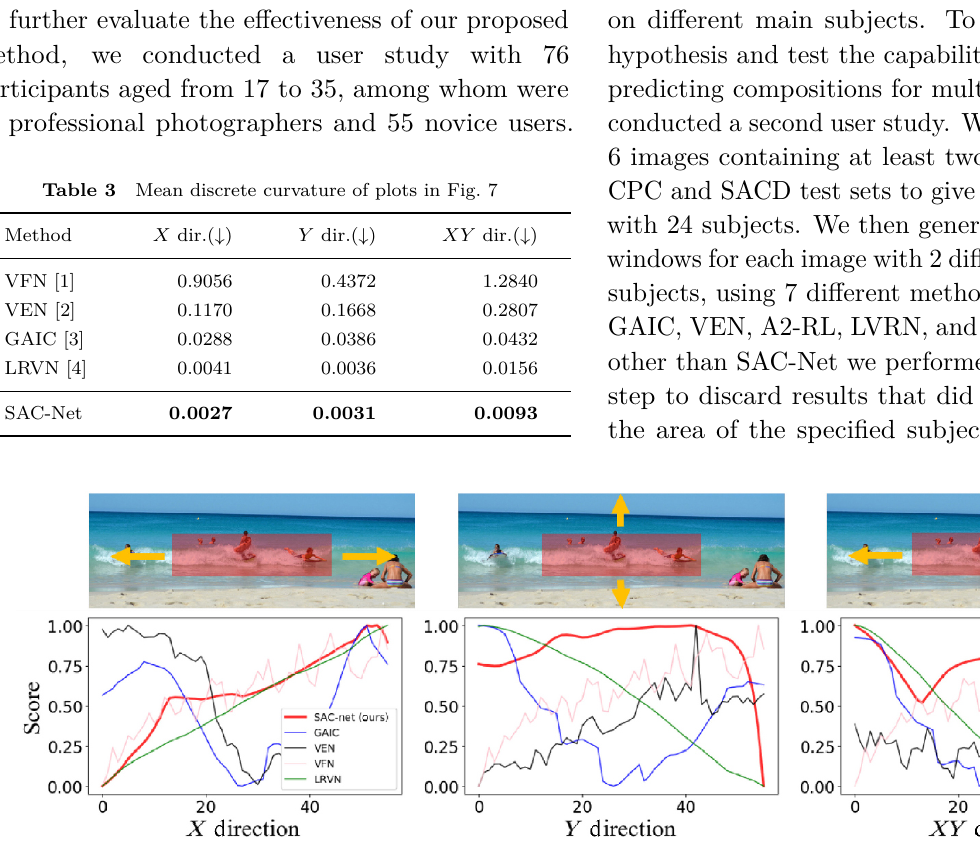
Fig. 7 Score continuity test. We fix a cropping window in the center of one image, expand the window in different directions, and plot the score curve predicted by five different methods. x -axis: number of pixels the cropping window has expanded in the corresponding direction. y -axis: score of the current